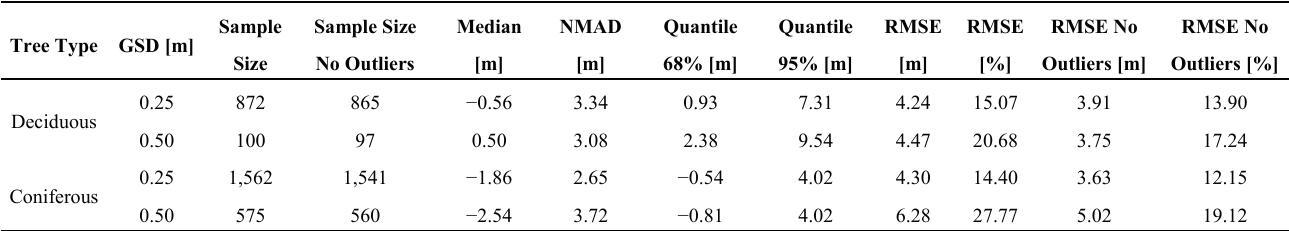
Table 6. Agreement of tree height calculated from the CHM with the terrestrially measured tree height. A threshold value of ±3 × RMSE was applied for outlier